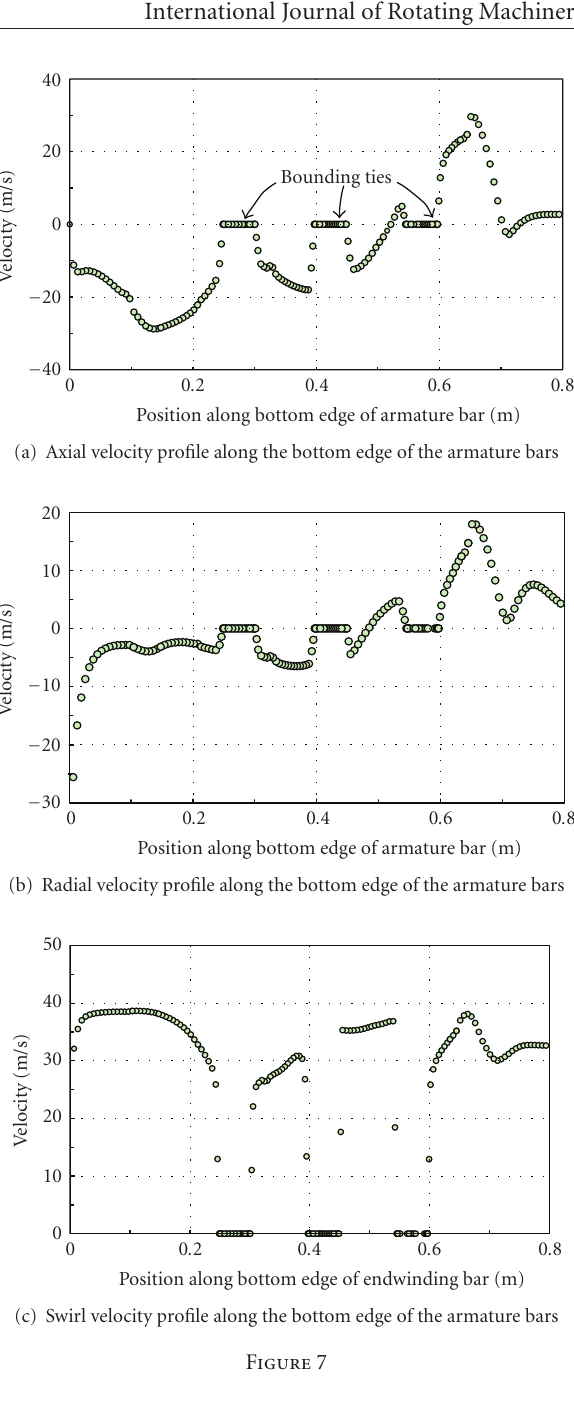
along the bar edges. The radial velocity distribution ( u r ) is displaced in Figure 7(b). At the bar root, which is near the rotor-stator gap entrance, the radial flow is negative due to the suction e ff ect of the gas flow through the annular rotor- stator gap. The radial velocity turns to the positive after the second bar tie. The swirl velocity u θ at the bottom edge of the armature bars is resulted from the rotor rotation. Unlike to the axial and radial velocities, the swirl velocity is more uniform; no negative values are observed (Figure 7(c)). In all cases, the velocity components vanish at the locations of the bar